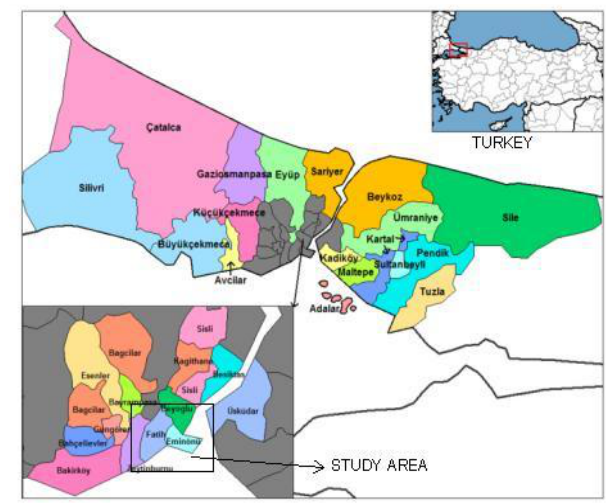
Figure 5. Location of the study area Fig. 5. Location of the study area.